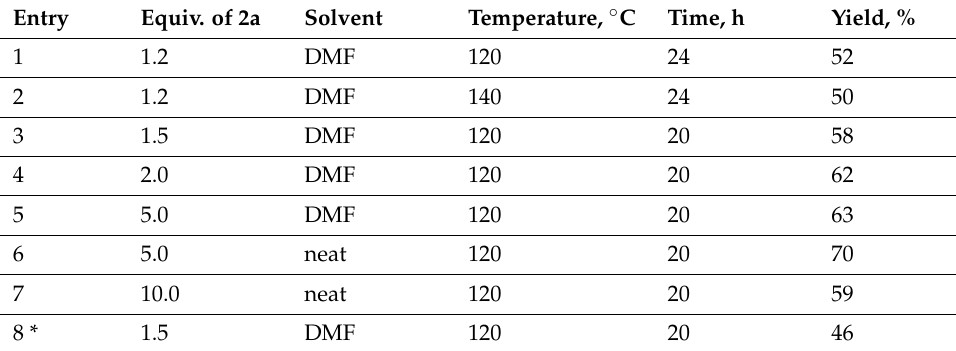
Table 1. Optimization of the reaction conditions.